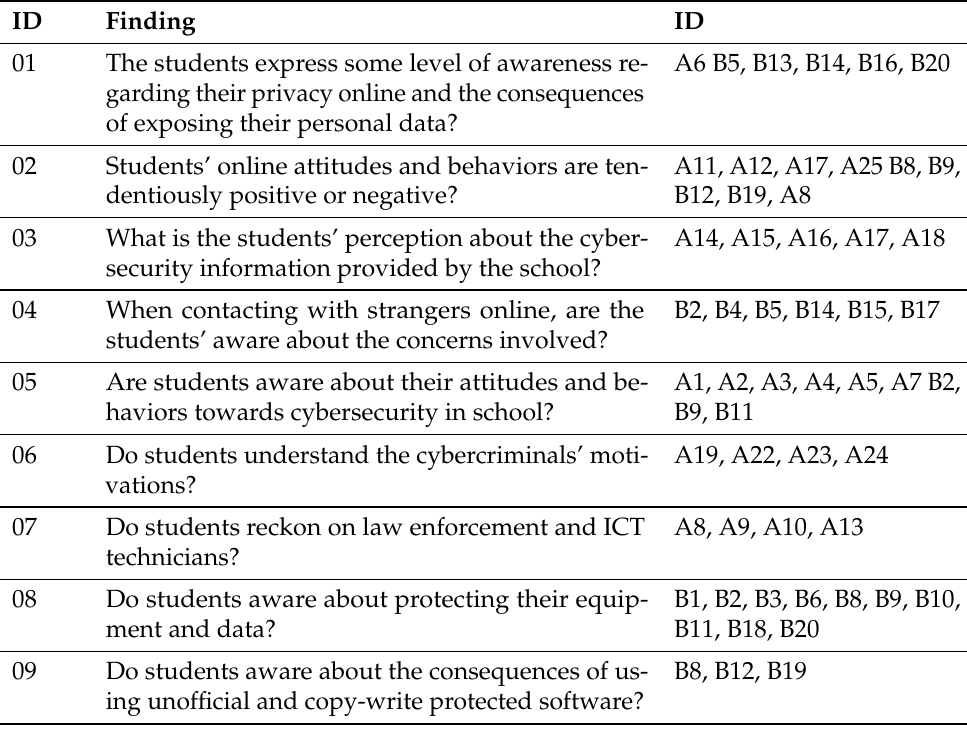
Table 3. List of findings and the corresponding questions of CsA-S and